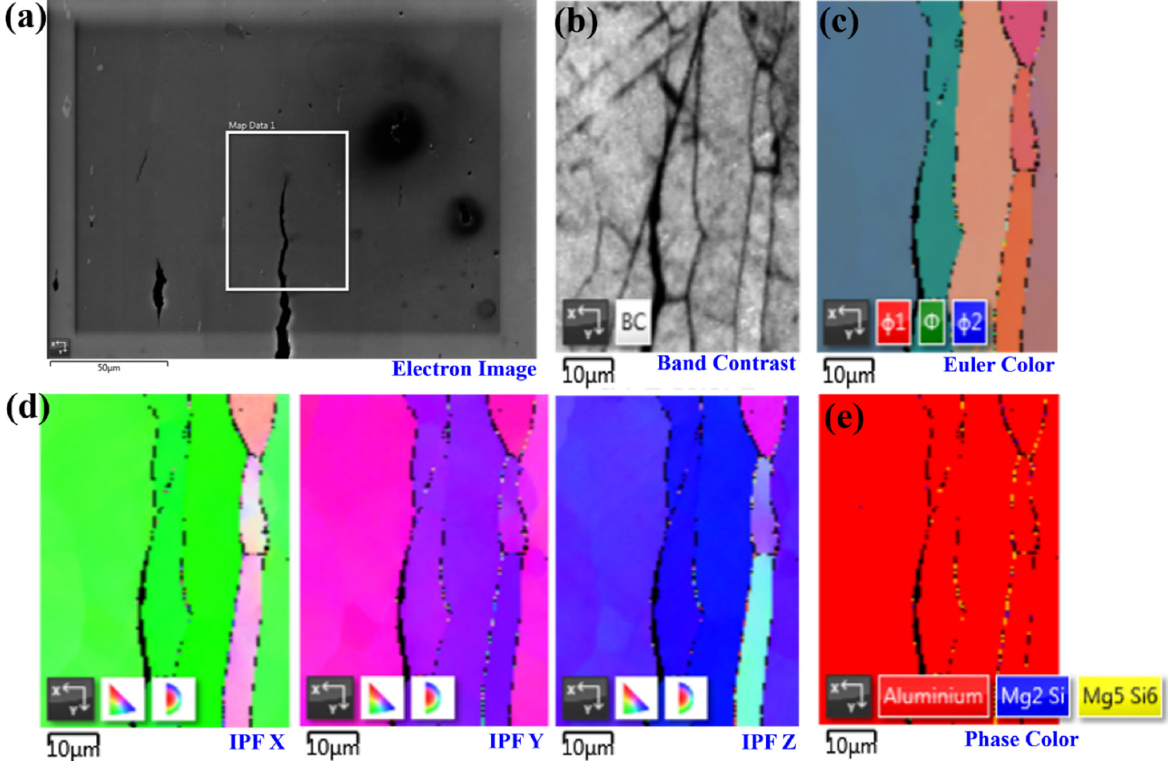
Figure 6. The classical cracking features at the IGSCC tips along the elongated grains, as characterized by EBSD: ( a ) the electron image of the crack tips together with precipitates and pits; ( b – e ) the characterizations of selected regions in terms of band contrast, Euler color, the inverse pole figure (IPF) of the x ‐ , y ‐ , and z ‐ axes, and the phase map, respectively.